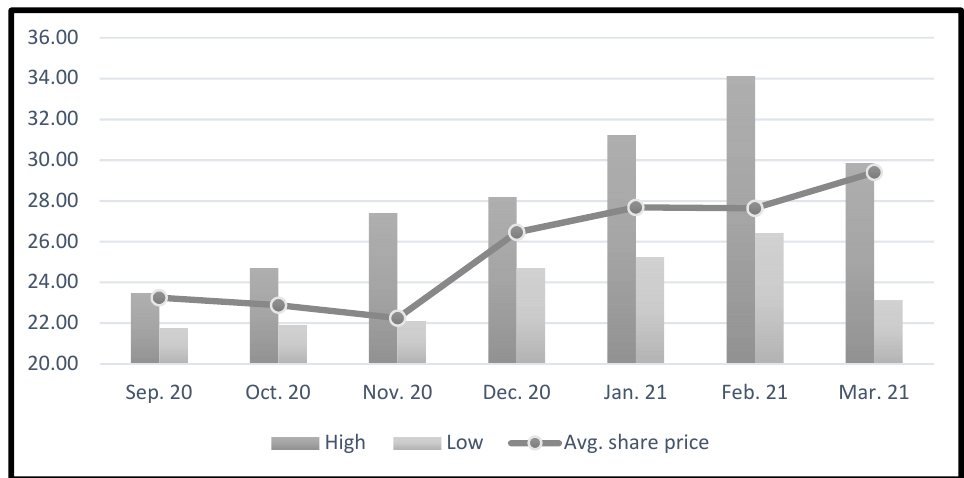
Figure 3. Pershing Square Tontine Holdings’ average monthly share price. Source: The illustration is based on the data extracted from NYSE.